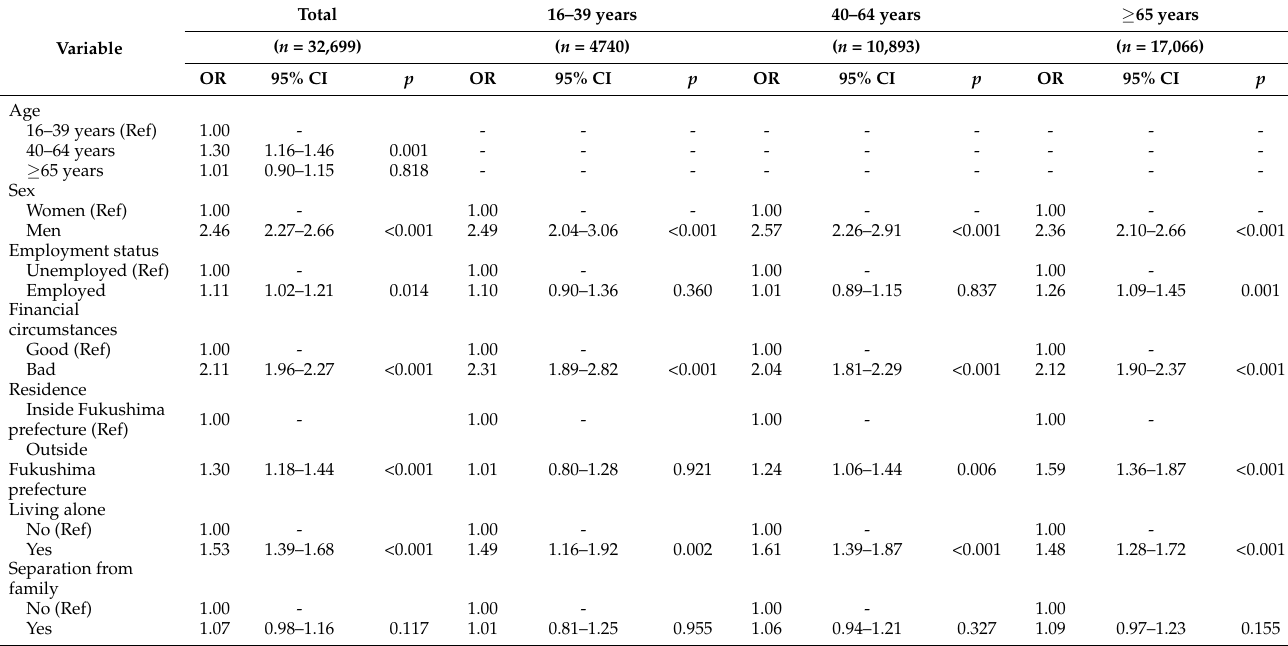
Table 3. The results of the multivariate logistic regression analysis regarding factors associated with having no one to consult according to age